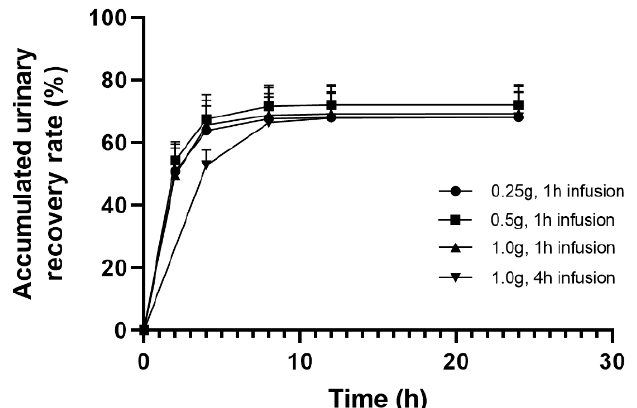
Figure 2. Mean segmented urinary recovery rates after a single intravenous infusion of doripenem in healthy subjects. Doripenem was infused for 1 h ( A ) or 4 h ( B ). Bars and error bars are the means and standard deviations from 12 subjects in each dose group.